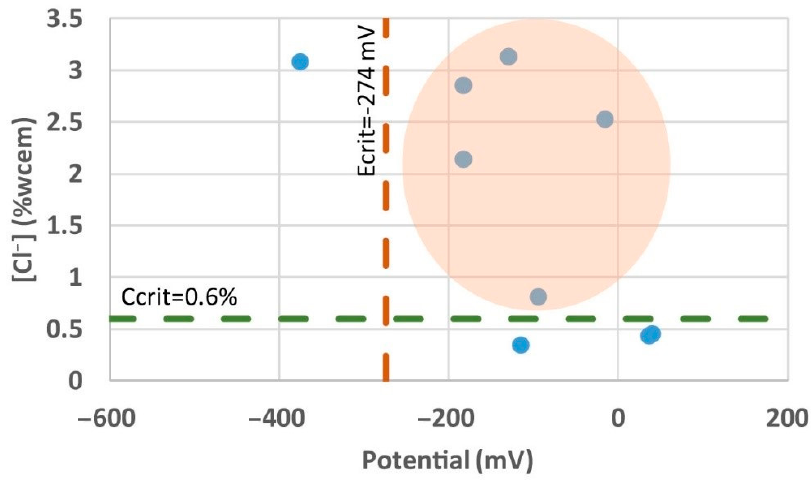
Figure 5. Chloride concentration vs. corrosion potential.